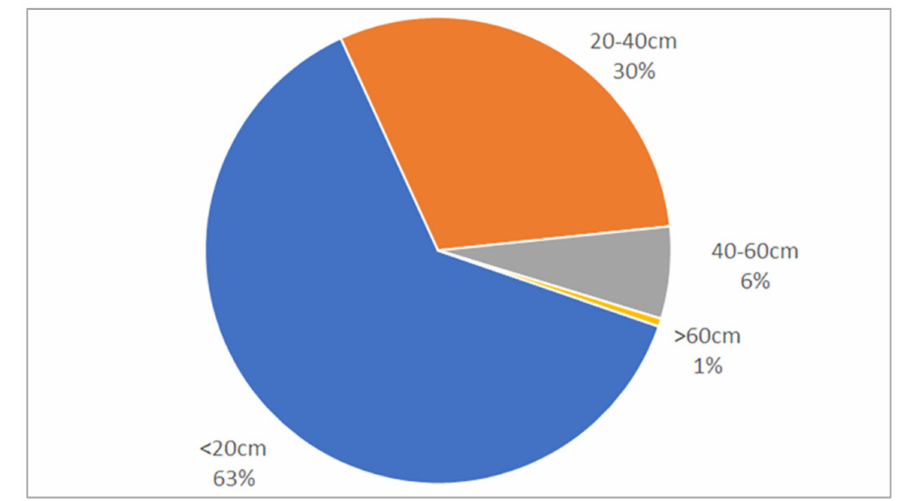
Figure 19. Summary of false negatives by DBH